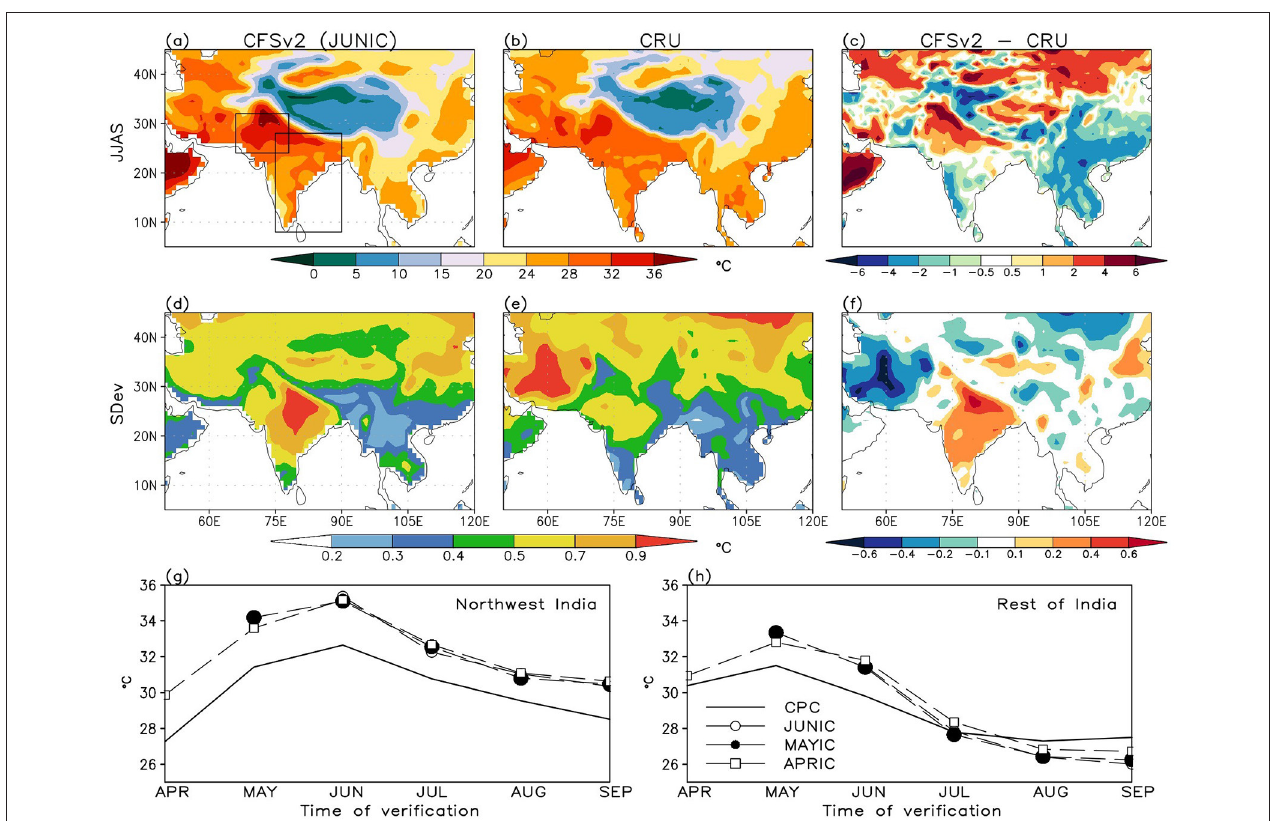
FIGURE 3 | Same as in Figure 1 , except for 2m air temperature. Observations are from the CRU. Units are in ◦ C.